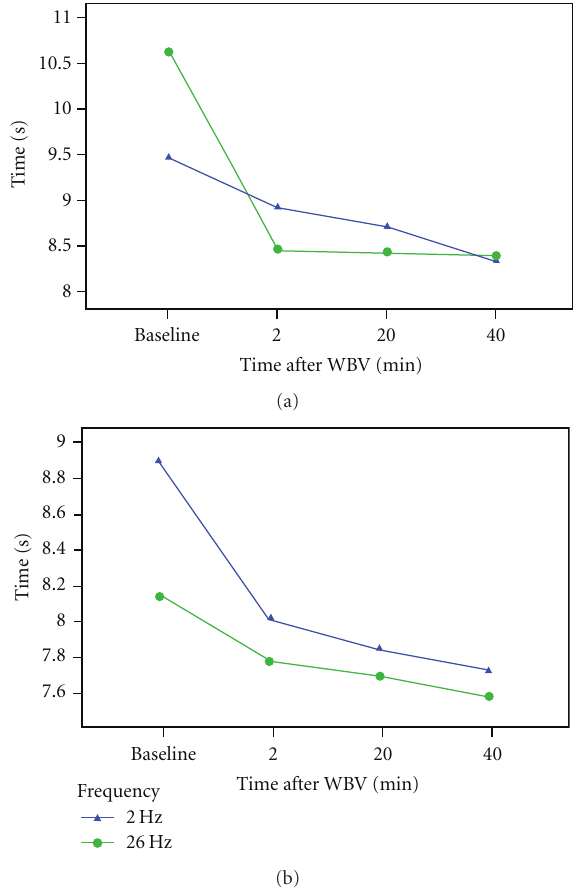
Figure 3: Time course of timed get up-and-go test in males (a) and females (b) at 2Hz and 26 Hz